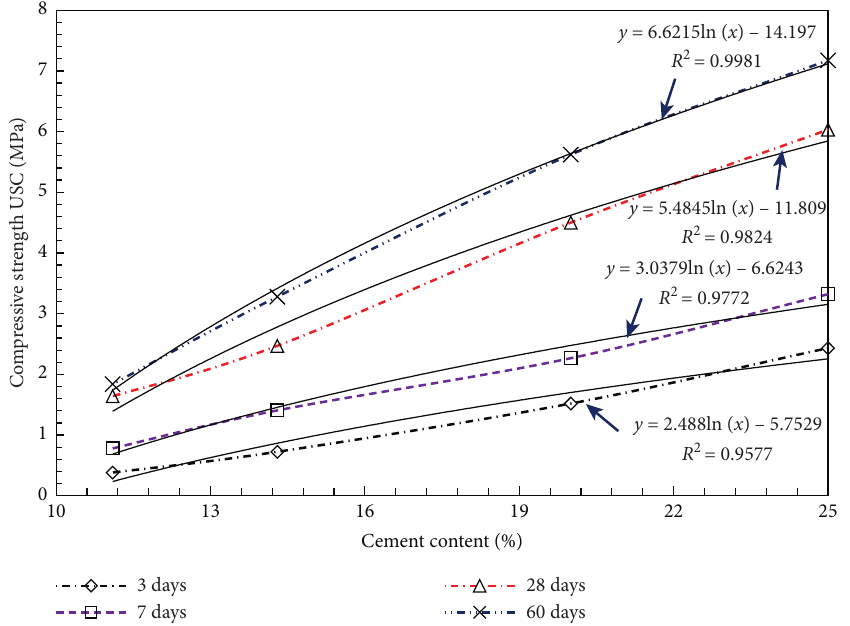
Figure 2: Effect of cement content on the strength of